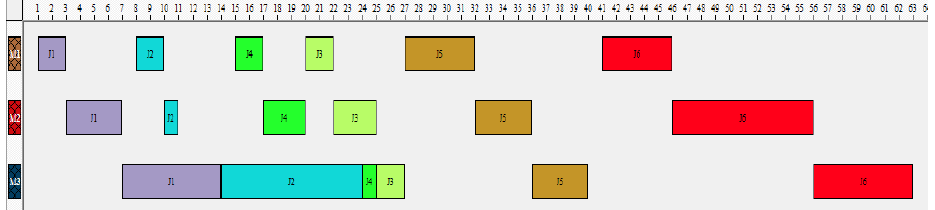
Figure 10. Gantt chart of the best solution with nine jobs by ACO.